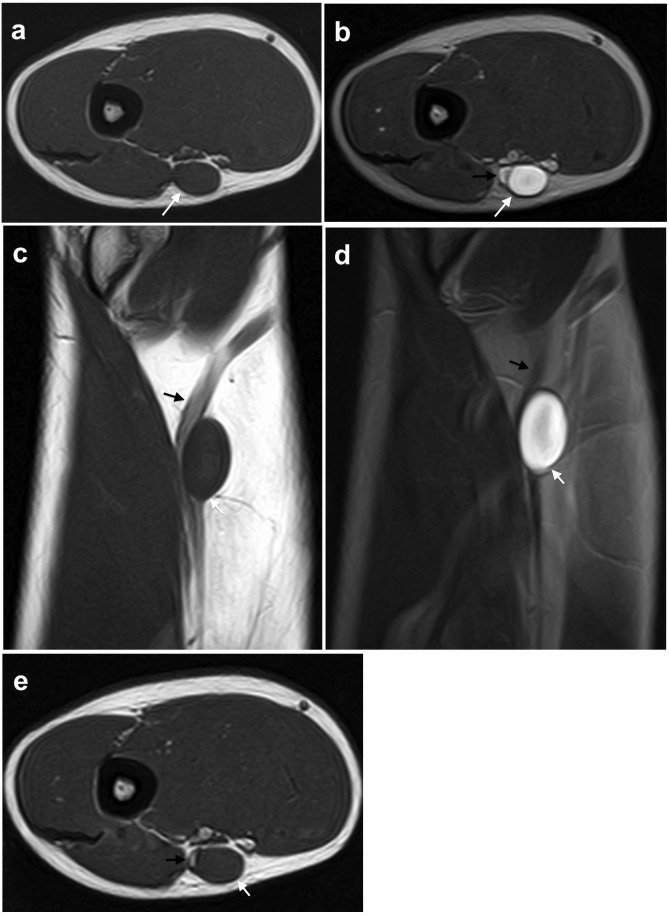
Magnetic resonance angiography of the left upper limb showing a cystic lesion with smooth walls and homogenous content (white arrows) adjacent to and in contact with the wall of the basilic vein (black arrows), in T1 axial (a), T2 axial (b), T1 coronal (c), and T2 coronal (d) views. Images acquired after administration of contrast, in T1 coronal (c) and T1 axial (e) views did not show contrast highlighting the lesion.